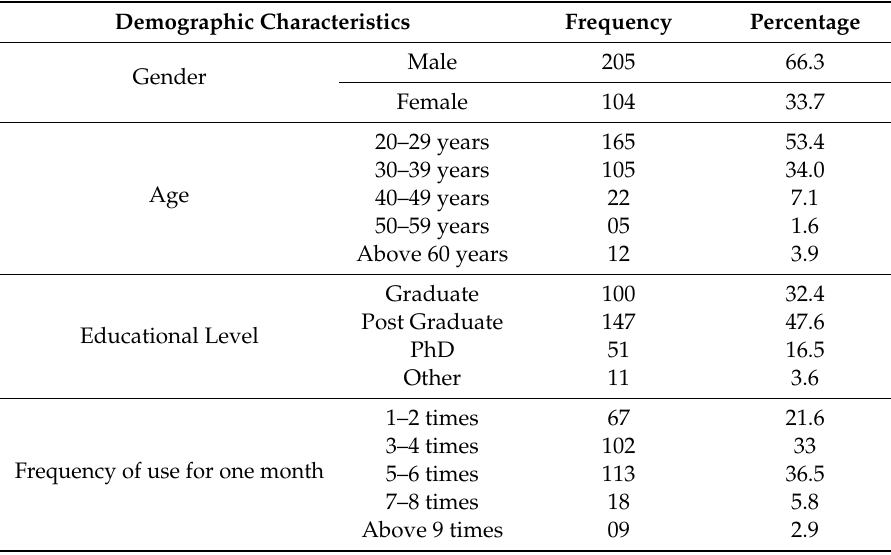
Table 1. Profile of